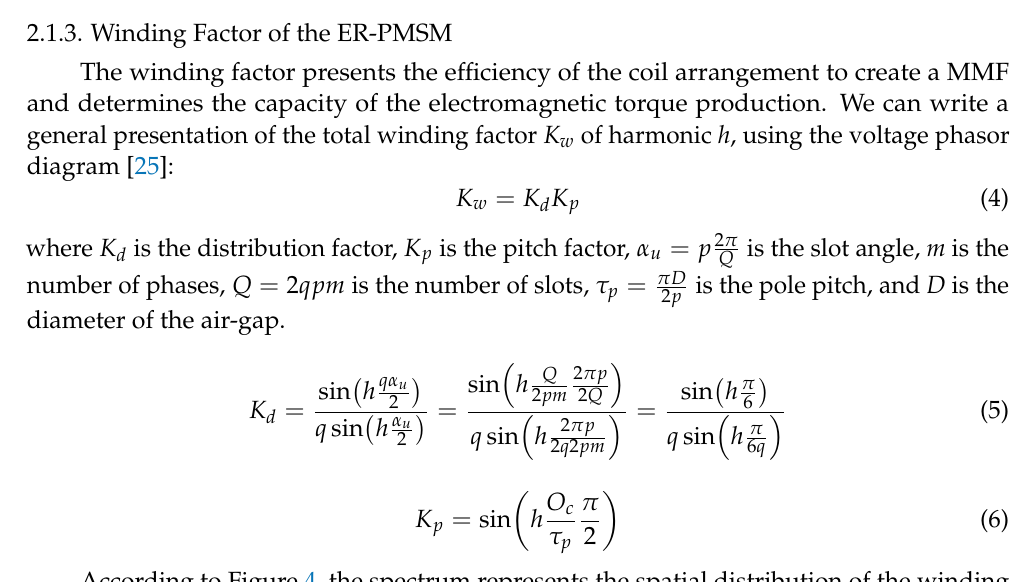
Figure 3. Harmonic spectrum of the winding function.